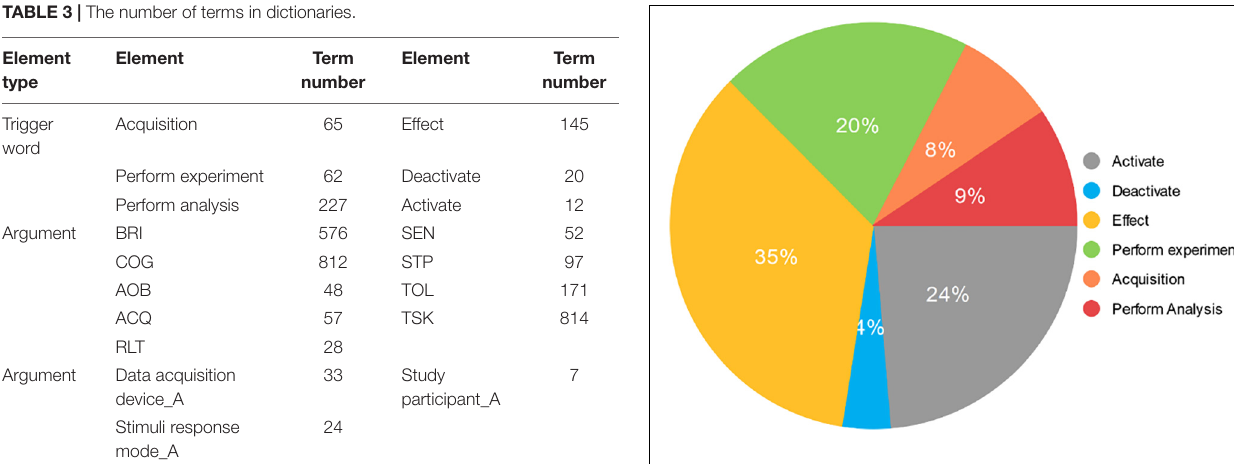
FIGURE 5 | The distribution of event mentions in the experimental data set. It consists of 3331 event mentions extracted from 677 neuroimaging articles. The “Activate” category includes 788 mentions and accounts for 24% of the total. The “Deactivate” category includes 128 mentions and accounts for 4% of the total. The “Effect” category includes 1169 mentions and accounts for 35% of the total. The “Perform experiment” category includes 665 mentions and accounts for 20% of the total. The “Acquisition” category includes 266 mentions and accounts for 8% of the total. The “Perform Analysis” category includes 315 mentions and accounts for 9% of the